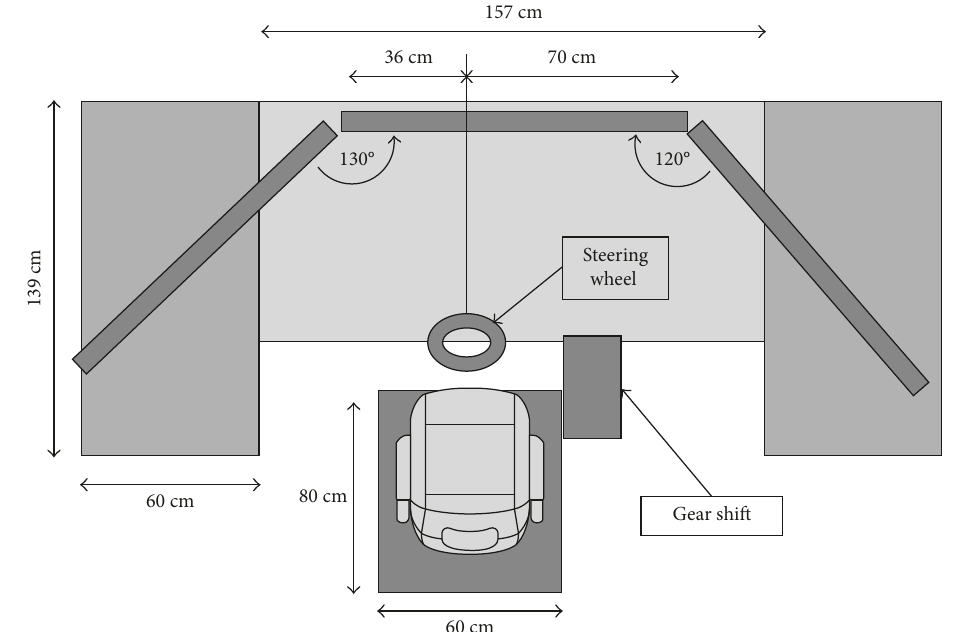
Figure 2: Top view of the driving simulator including tables, monitors, seat, gear shift, and steering wheel. Pedals are under the table (not